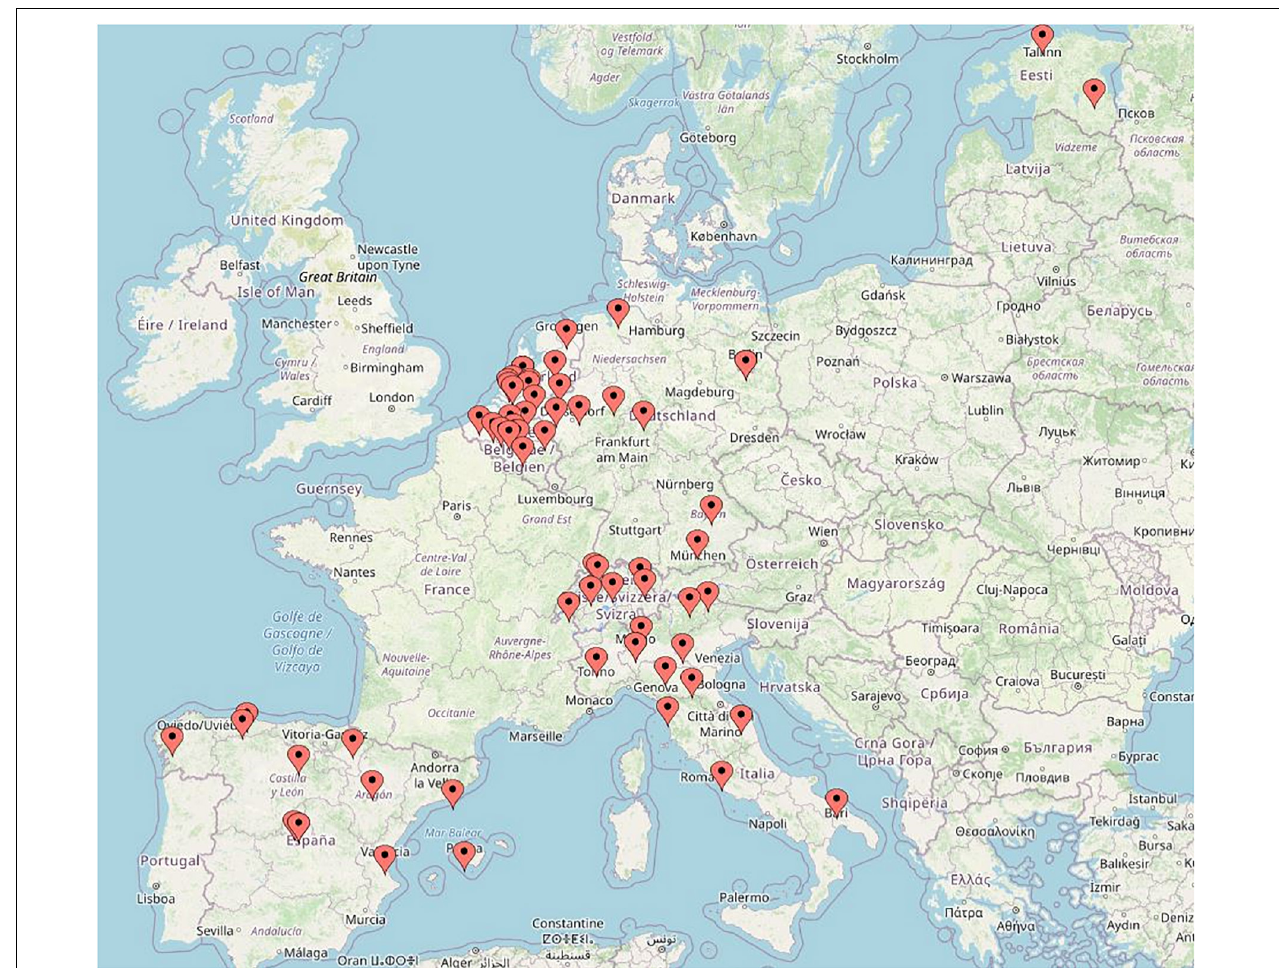
FIGURE 1 | Geographic locations of participating laboratories in this